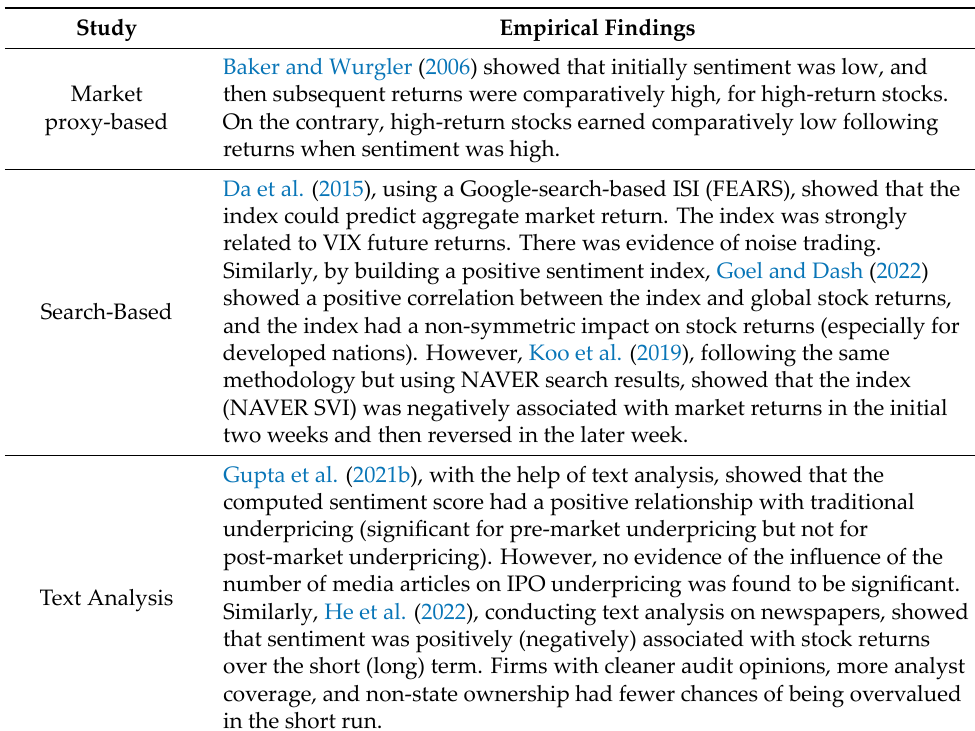
Table 6. Investor sentiment index